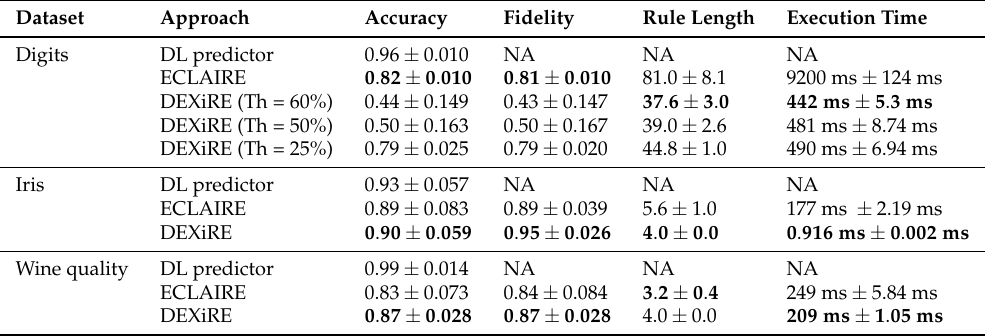
Table 2. Summary table Scenario SC2 (multiclass classification) showing results for Rule extraction approach, Accuracy, fidelity, rule length, and execution time for each dataset. Numerical results are reported with average value ± standard deviation . The best results in each dataset are shown in